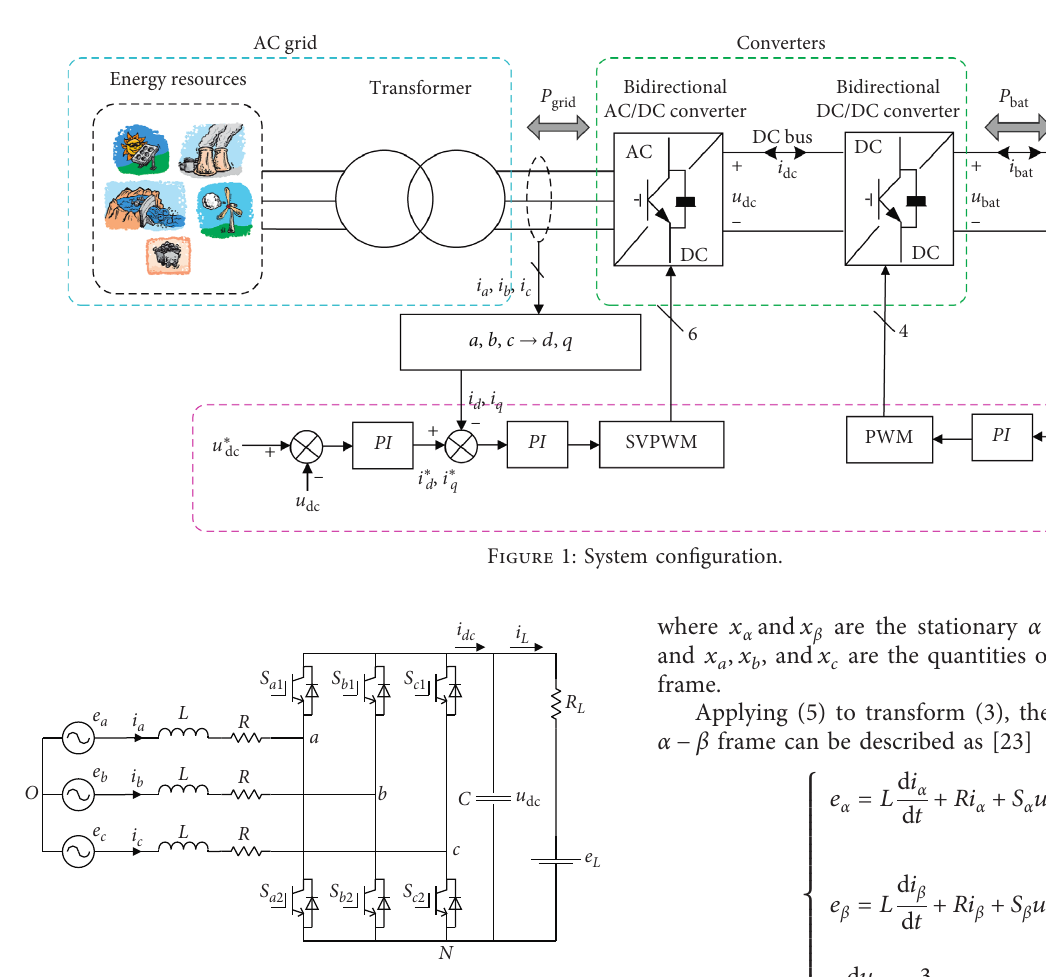
Figure 2: The circuit of bidirectional AC/DC